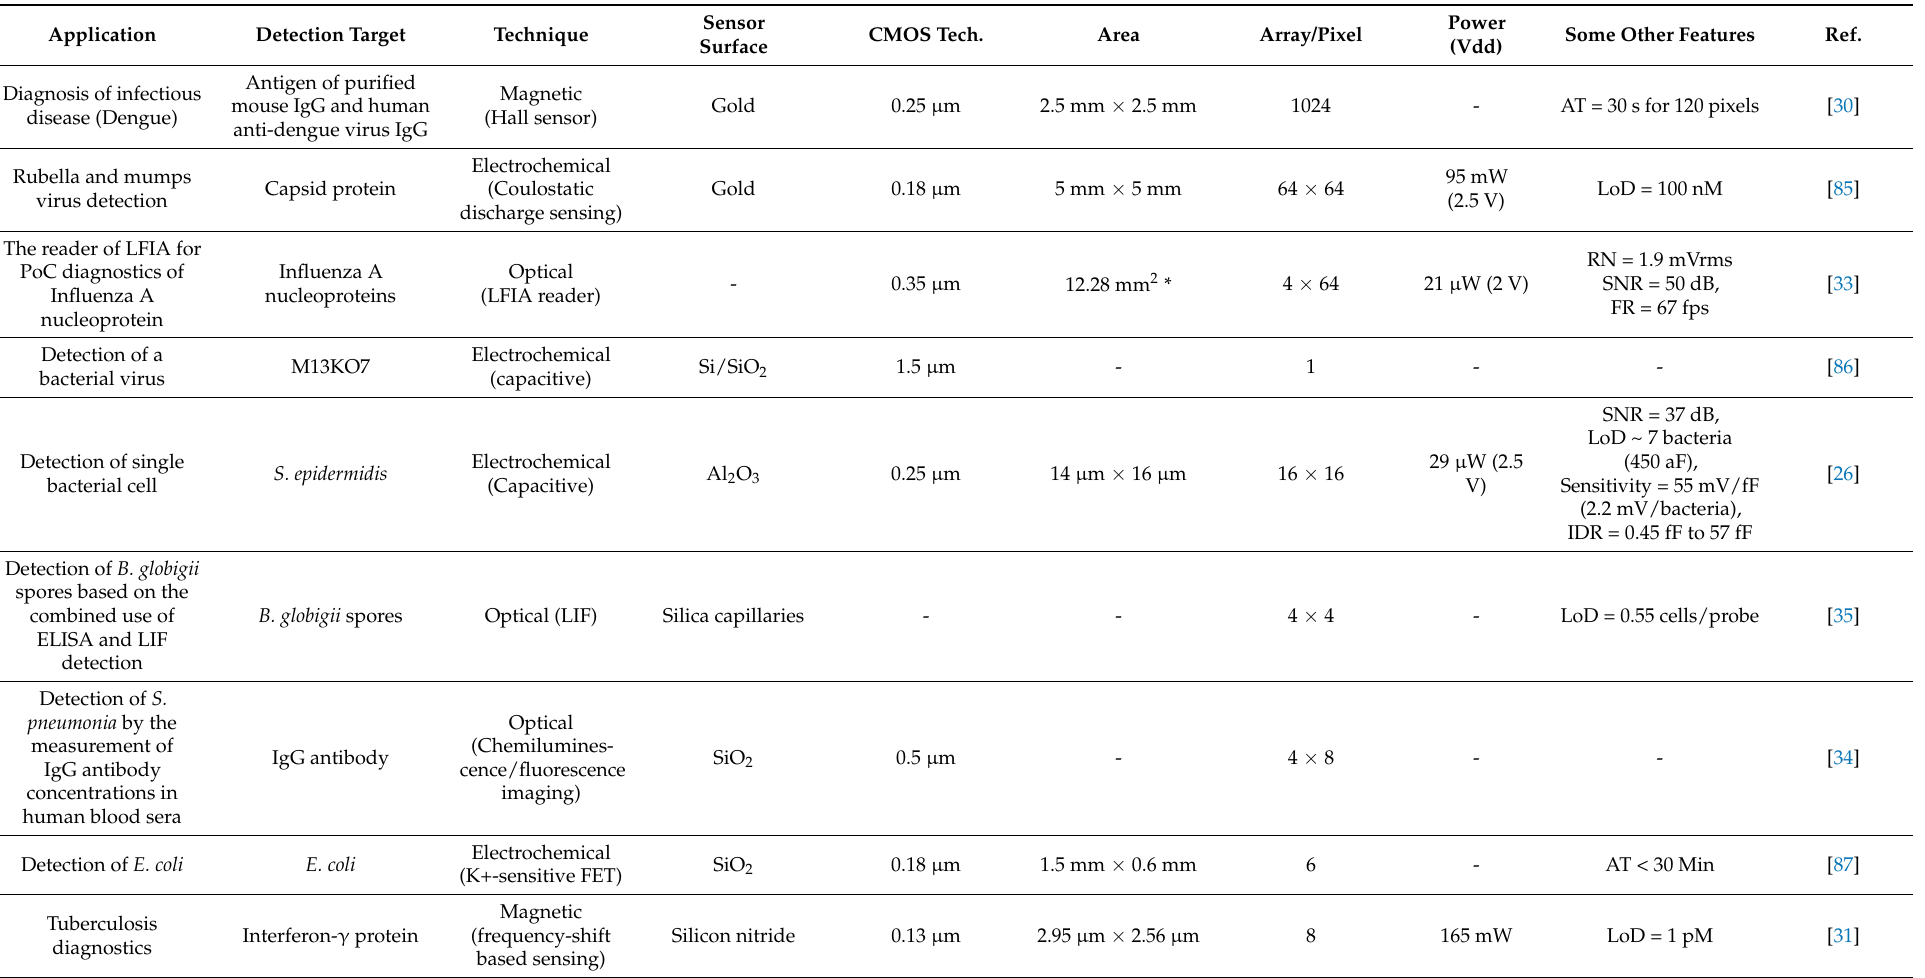
Table 4. CMOS-based biosensors reported for the diagnosis of various infectious